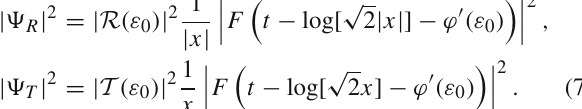
of the Fock basis. Everywhere, the oscillator frequency is taken to be ω / 2 π = 10MHz; d the OTOC in Eq. (8) for various pure initial Fock √ 0 ¯ h / 2 m ω superpositionstateswithdrivingstrength ξ = 0 . 01,and x 0 = is vacuum position uncertainty; e the OTOC in Eq. (8) for different Lya- punov exponent parameters (driving strengths) ξ ; the initial pure state √ is | (cid:15) in (cid:7) = ( | 0 (cid:7) + | 1 (cid:7) )/